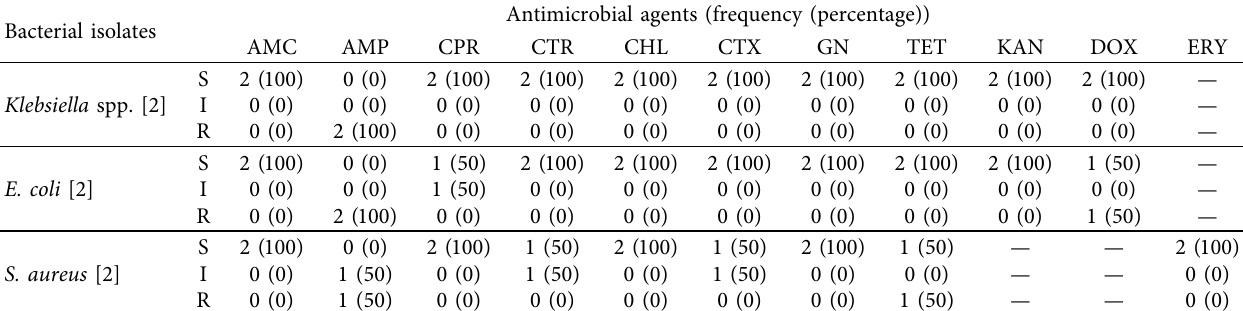
Antimicrobial agents (frequency (percentage))